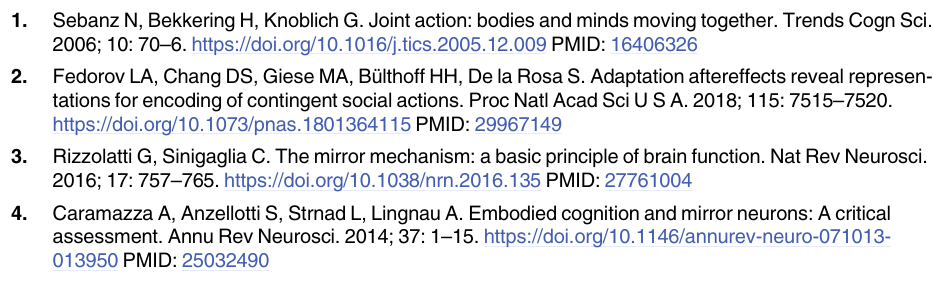
S1 Fig. Action discriminability: Data averaged for video duration conditions. Averaged d- prime values as a function of video durations (short, medium, long) and facial emotions of the agents (angry, happy). Video duration conditions were aggregated on basis of the number of added frames. Short duration relates to 1–5 added frames, medium duration to 6–10 added frames and long duration to 11–15 added frames. Error bars depict the standard error of the mean. S2 Fig. Emotion bias: Data averaged for video duration conditions. Proportion of punch responses as a function of facial emotions (angry, happy), actions (fist bump, punch), and varying video clip durations (short, medium, long). Video duration conditions were aggre- gated on basis of the number of added frames. Short duration relates to 1–5 added frames, medium duration to 6–10 added frames and long duration to 11–15 added frames. Error bars depict the standard error of the